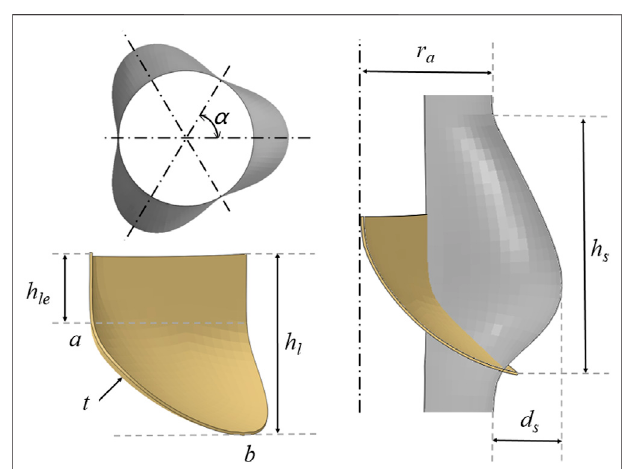
FIGURE 2 | Schematic diagram of the geometry of the aorta and valve lea fl ets and de fi nition of relevant dimensions of the aorta and valve lea fl ets.